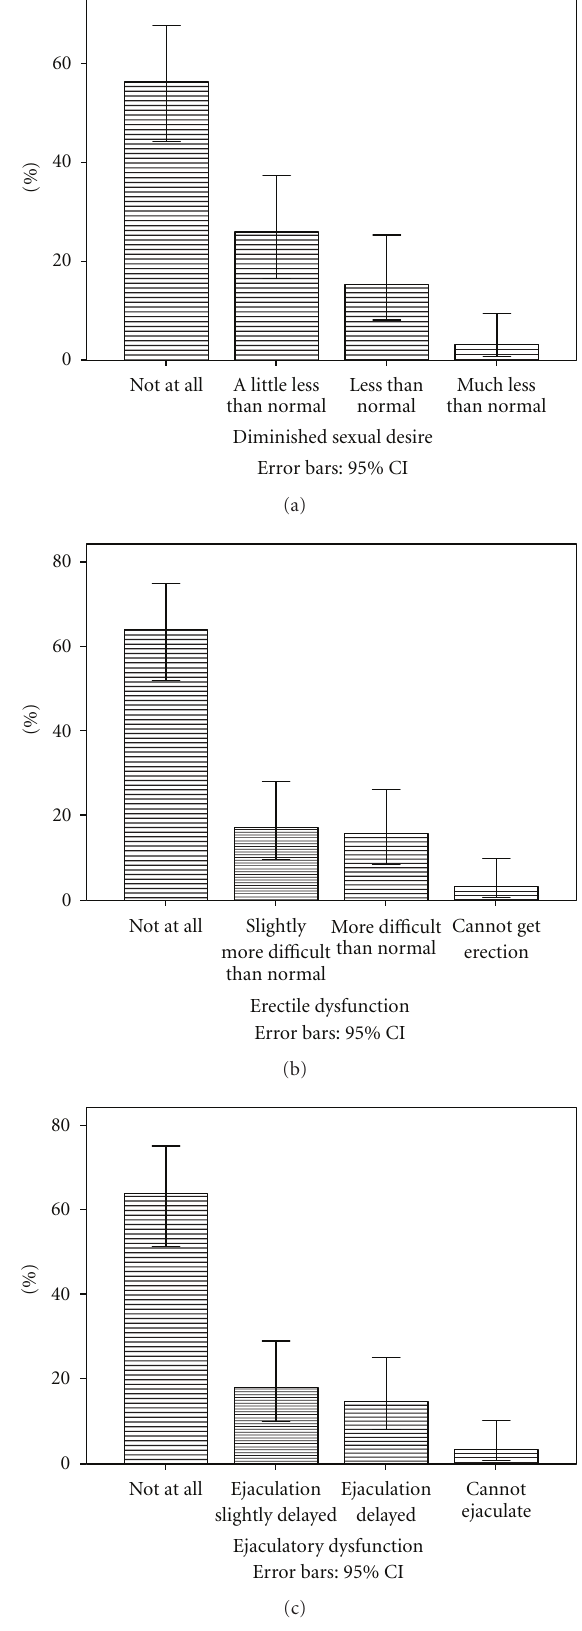
Figure 1: Distribution of sexual